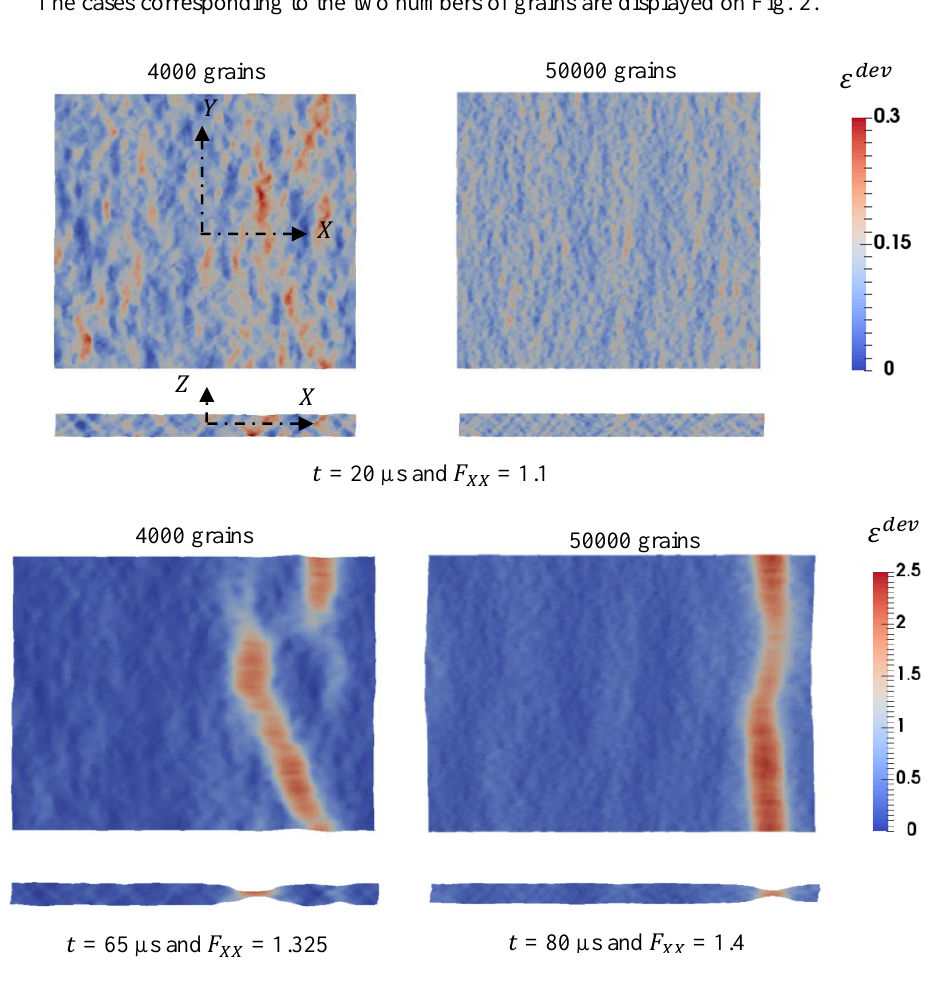
Fig. 2. Maps of deviatoric (Hencky) strain 𝜀 𝑑𝑒𝑣 in average plane and cross section for the 4000 and 50000 grain aggregates for stretching rate 𝐹̇ 𝑋𝑋 = 5000 s -1